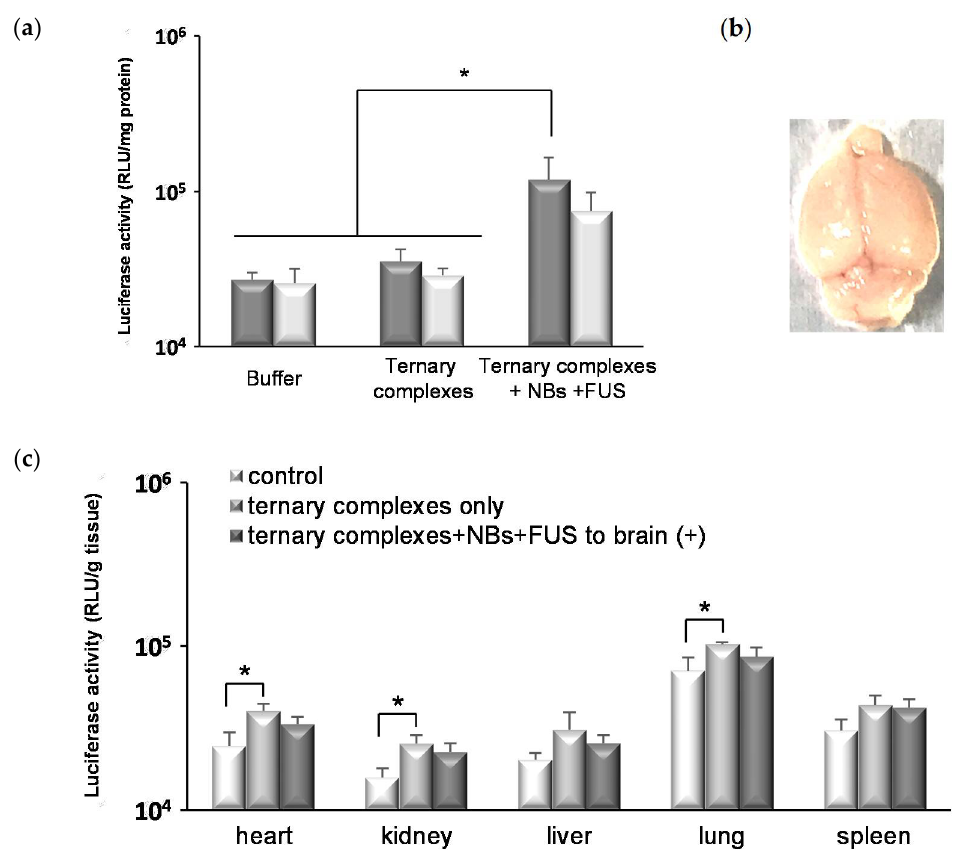
Figure 6. The effects of systemic gene delivery with the ternary complexes, NBs, and FUS. The ternary complexes (pDNA 48 μg/mouse, N/P 10, PEG-PEI:RVG-R9 = 8:2) and NBs (100 μg/mouse) were injected into the mice tail vein and the right hemisphere was concurrently exposed to FUS (intensity: 0.4 kW/cm 2 , duty: 10% (msec), time: 90 s). One day after the transfection, various tissues were collected and the luciferase activities of ( a ) brain, ( c ) heart, kidney, liver, lung, and spleen were analyzed. ( a ) Dark gray column: the right hemisphere exposed to FUS. Light gray column: the left hemisphere unexposed to FUS. The bars show the mean and S.D. ( n = 3–4). * indicates p < 0.05 using a one-way ANOVA with Tukey’s post-hoc test. ( b ) The image of brain one day after the transfection by the combination of ternary complexes, NB, and FUS (intensity: 0.4 kW/cm 2 , duty: 10% (msec), time: 90 s).